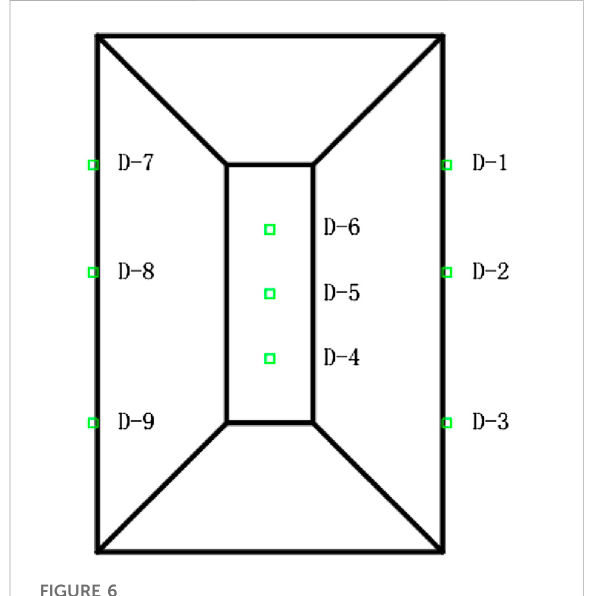
FIGURE 6 The location of settlement observation